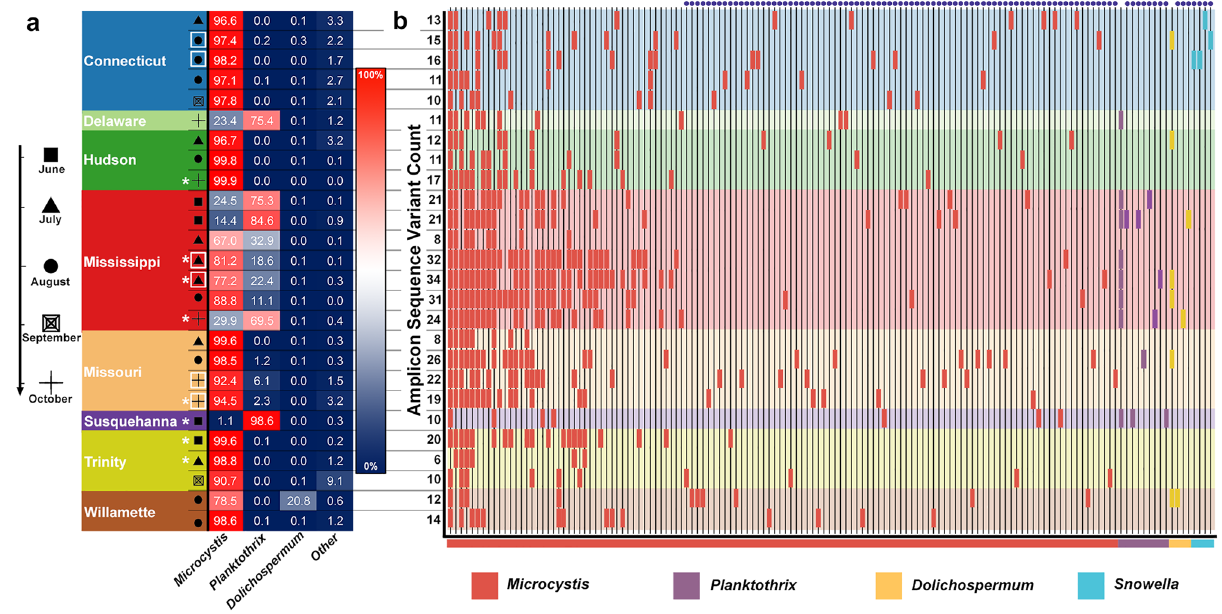
Figure 4. mcyE sequencing. ( a ) Percentage of reads from mcyE amplicon sequencing that are derived from various potential toxin producing cyanobacterial genera from each U.S. river sample across various sampling months (indicated by shapes, see legend). Greater percentages are shown as dark red, lower percentages as dark blue. Samples that did not possess the mcyE sequence (see text) are not included. ( b ) Amplicon sequence variants (ASVs) assigned to each river sample. The legend for river and date of sample in ( a ) applies across the panels to ( b ). Each vertical line represents a unique ASV with bars placed along each line to indicate the presence of that ASV in the corresponding sample row. ASV lines are ordered left to right by abundance and grouped by genus of origin. Total ASV counts per sample are indicated on the left axis line. ASVs unique to a single sample are indicated along the top with purple dots. The color of each bar and the colors along the bottom indicate the genus to which each ASV was taxonomically assigned (legend at bottom). Replicates are indicated by a box around sample date shape. Samples with detectible microcystin toxin levels are indicated by an